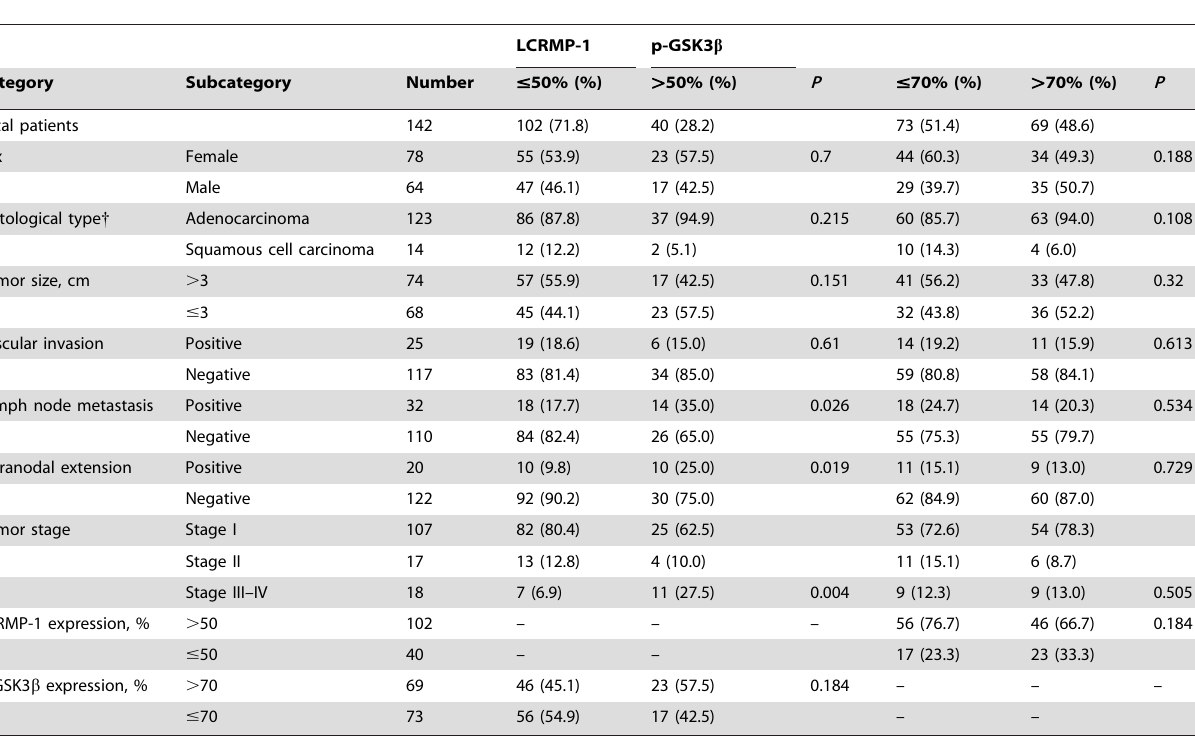
Table 1. LCRMP-1 and phosphorylated GSK3 b expression in relation to clinical parameters and pathological characteristics*.